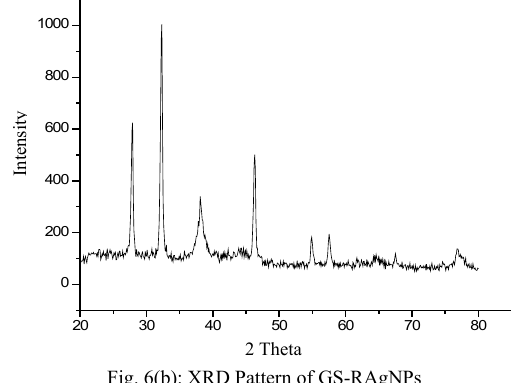
GS-RAgNPsFig. Fig. 5(a): EDAX and SEM of GS-SAgNPs Fig. 6(a): XRD Pattern of GS-SAgNPs Fig. 5(b): EDAX and SEM of GS-RAgNPs Fig. 5(a): EDAX and SEM of GS-SAgNPs Fig. 5(b): EDAX and SEM of Fig. 6(b): XRD Pattern of GS-RAgNPs Fig. 5(b): EDAX and SEM of GS-RAgNPs Fig. 6(a): XRD Pattern of GS-SAgNPs Fig. 6(a): XRD Pattern of GS-SAgNPs Fig. 6(b): XRD Pattern of Fig. 6(b): XRD Pattern of GS-RAgNPs